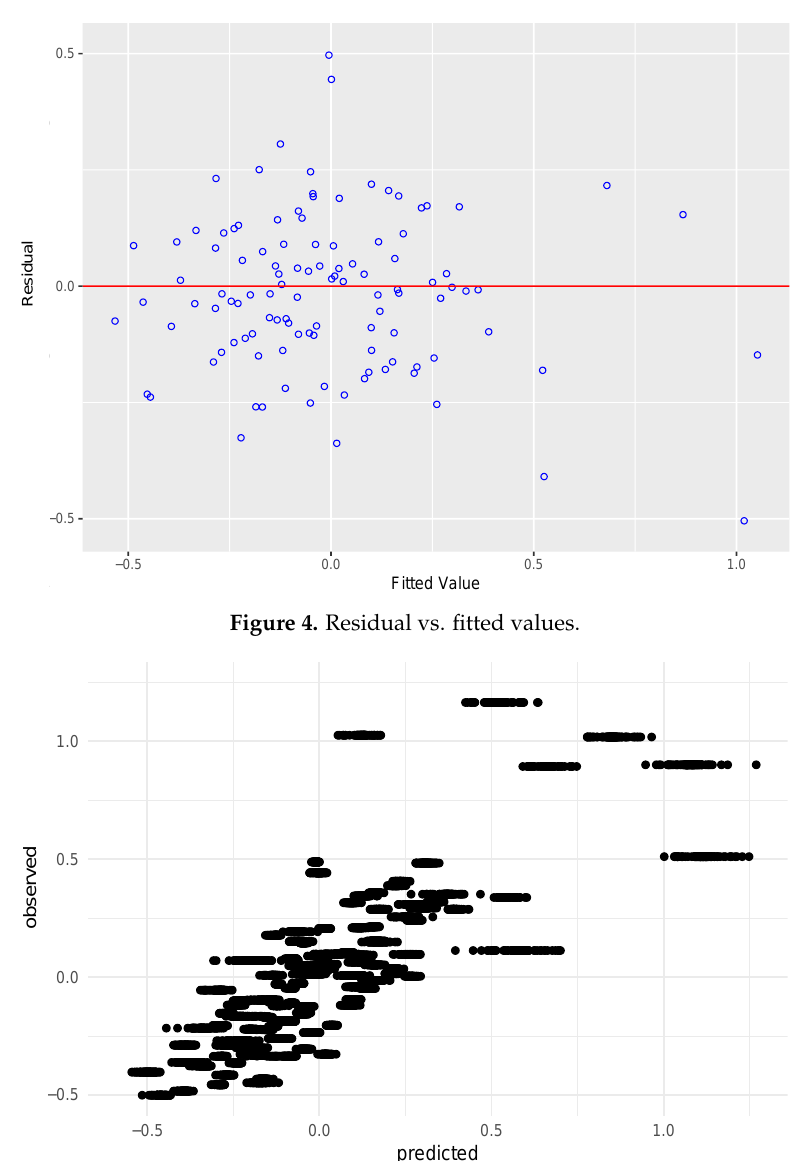
Figure 5. Cross-validated observed versus predicted values for all the